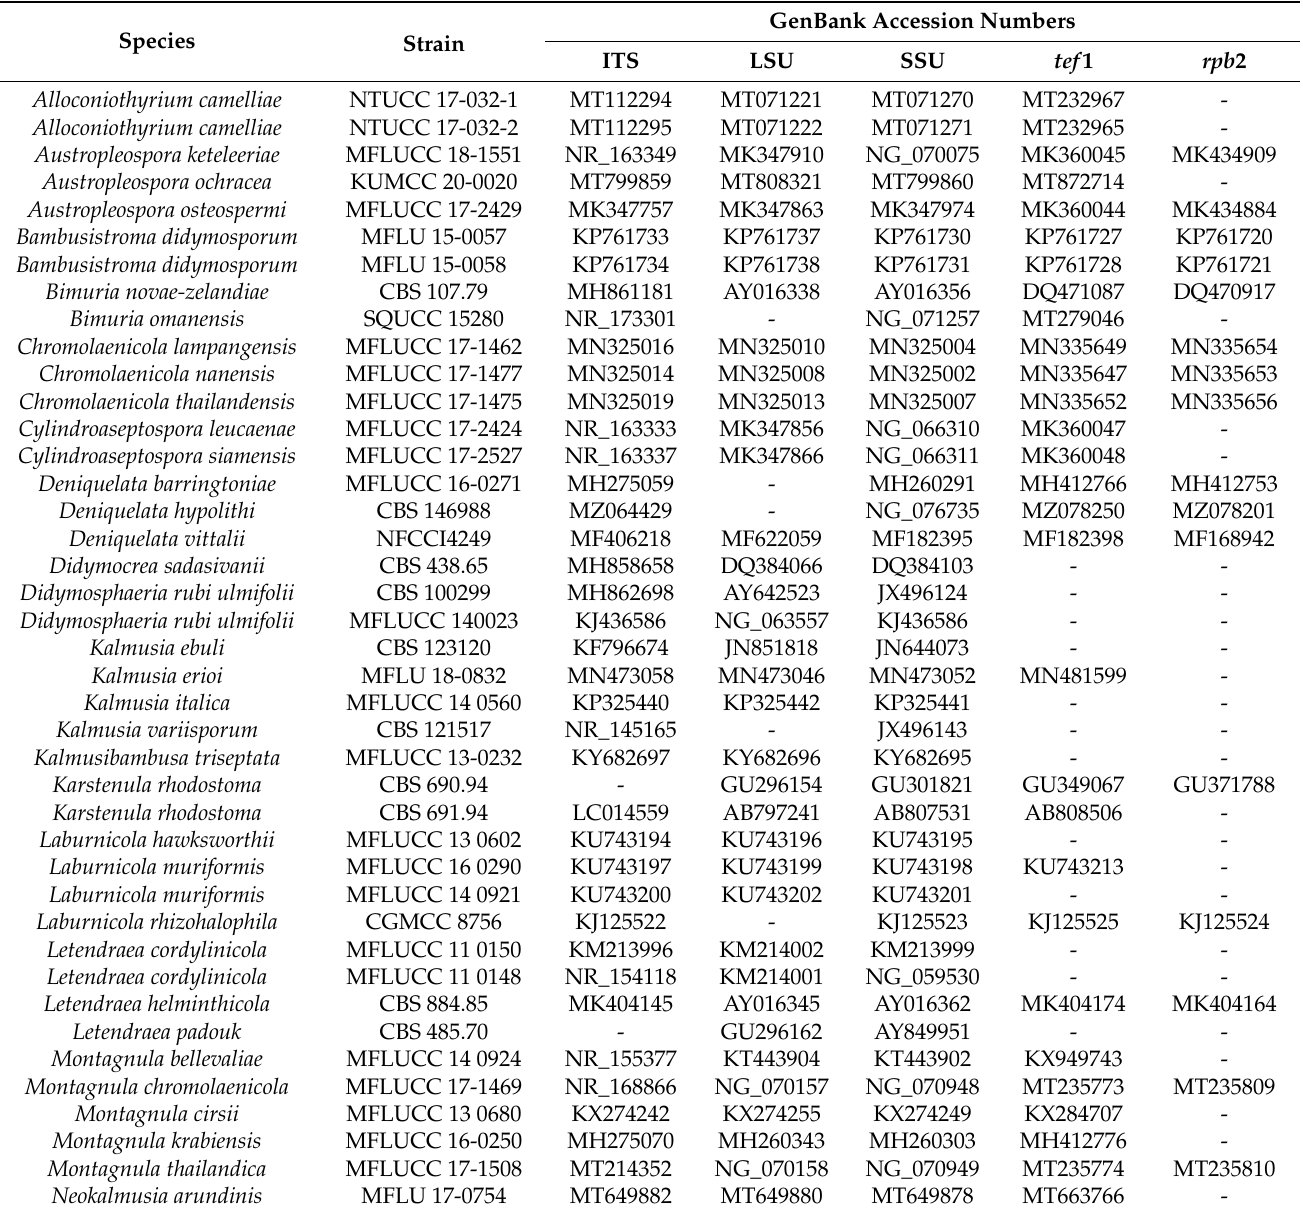
FigTree v1.4.0 program [33] was used to visualize the phylogenetic trees and reorga- nized in Microsoft Power Point (2007). The finalized datasets and trees were submitted to TreeBASE, submission ID: 29569 (http://purl.org/phylo/treebase/phylows/study/TB2: S29569 (accessed on 17 March 2022)). Table 1. Taxa used in the phylogenetic analyses of Didymosphaeriaceae and their corresponding GenBank numbers of partial ITS, LSU, SSU, tef 1, and rpb 2 sequences. Isolates/sequences in bold were isolated/sequenced in the present